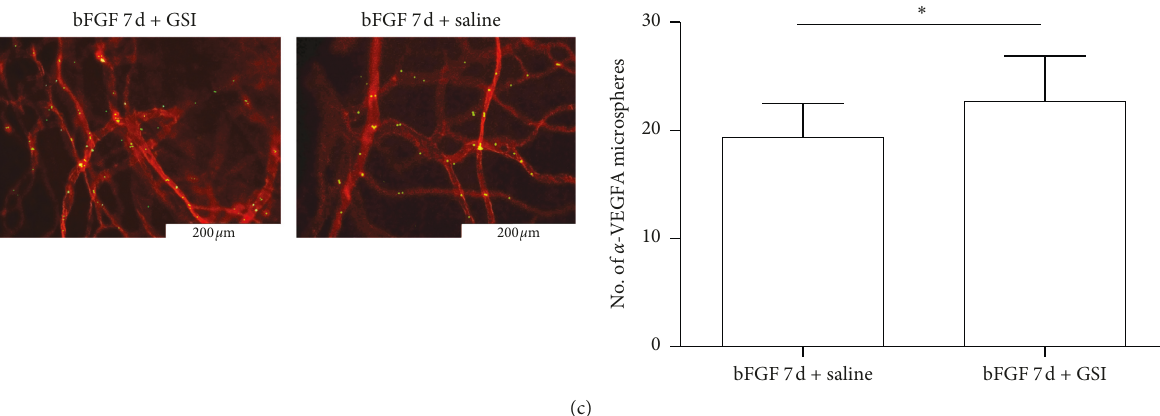
Figure 6: Vascular areas of lymphangiogenesis and hemangiogenesis in the GSI groups. (a) Representative western blot for VEGF-A in the GSI group; ∗ P < 0 . 05. (b) Quantitative analysis of lymphangiogenesis and hemangiogenesis in the GSI group ( n � 5); ∗ P < 0 . 05 (bar, 1000 μ m; 100 μ m). ∗ Sites of pellet implantation. (c) α -VEGF-As mAb-conjugated microspheres (green) and rhodamine-conjugated conA (red) in GSI and GSI-control groups (day 7; n � 5) ( ∗ P < 0 . 05; bar, 200 μ m).